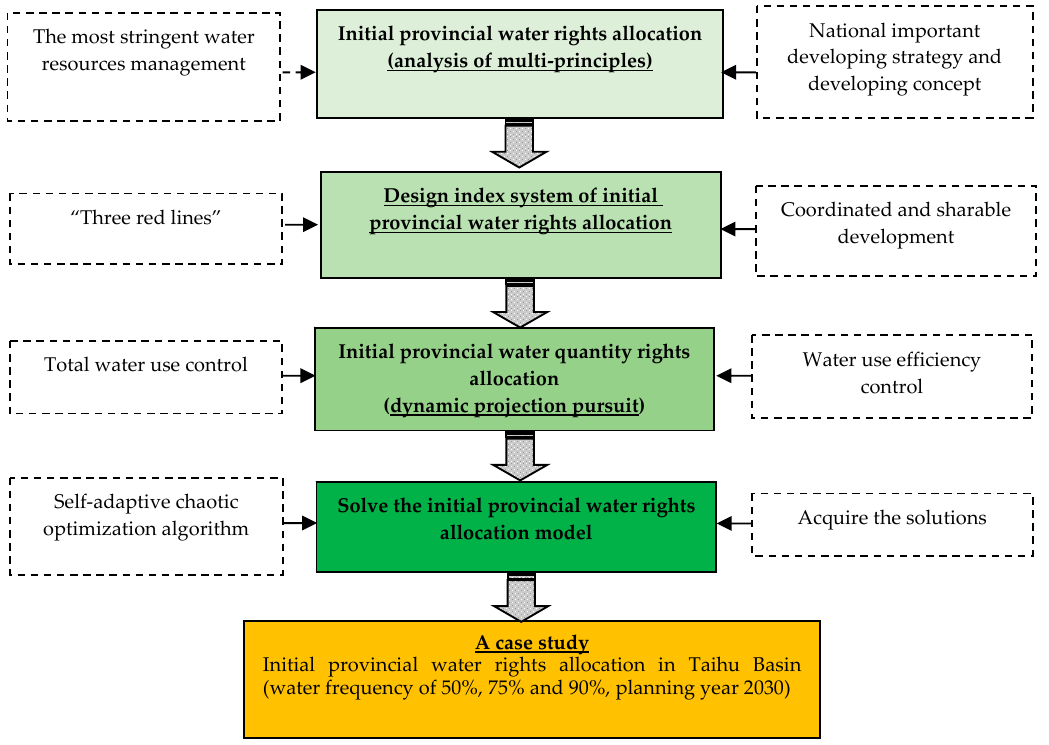
Figure 2. Outline of initial provincial water right allocation based on most stringent water resources management.